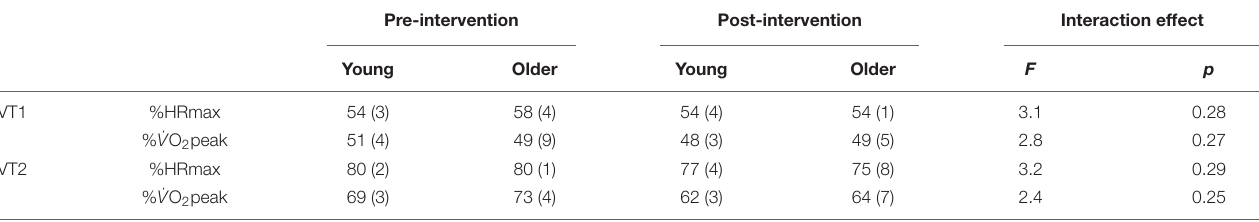
TABLE 2 | Results on relative intensities reached at the first and second ventilatory thresholds (VT1 and VT2) before (pre-intervention) and after (post-intervention) the supramaximal cycling exercise (SCE) intervention for both young and older groups. Pre-intervention Post-intervention Interaction effect Young Older Young Older